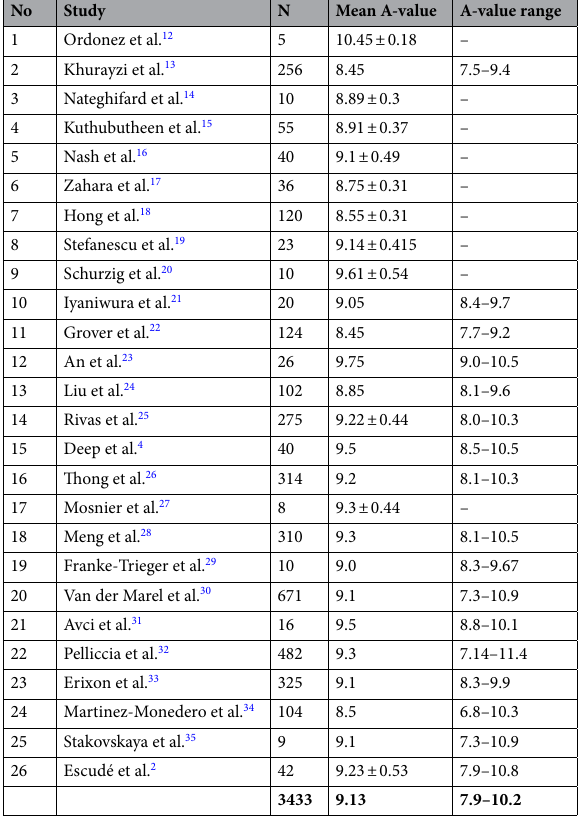
Table 1. Literature search of studies pertaining to A-value